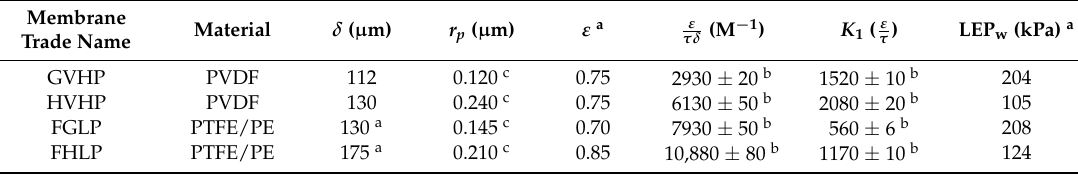
Table 2. Properties of hydrophobic membrane using DCMD tests.